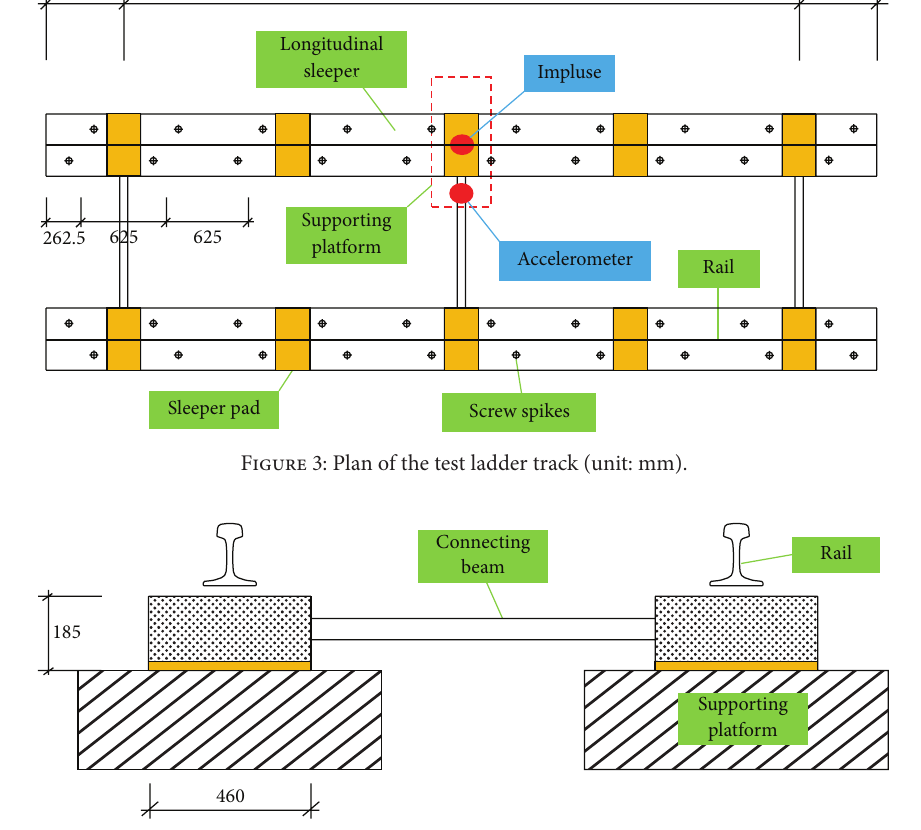
Figure 4: Cross section of the test ladder track (unit: mm).